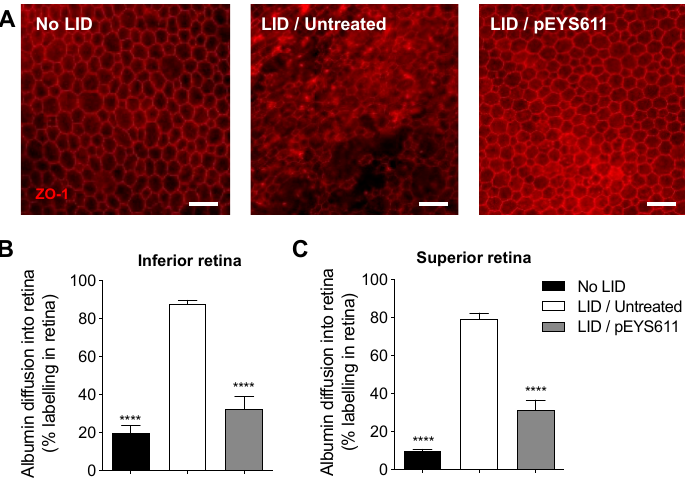
Figure 6. pEYS611 preserves the integrity of the outer BRB following light damage. Rat received a single ciliary muscle electrotransfection of pEYS611 (30 µg/eye) on D-3 or left untreated ( n = 8 animals/group). Except for unexposed animals (no LID), retinal degeneration was induced on D0 by 24 h of bright light exposure (6500 lux). ZO-1 and albumin staining were performed on D8. ( A ) Representative images of flat-mounted retina/RPE/choroid ZO-1 staining at a distance of 1500–2000 µm from the ON. Scale bar, 50 µm. ( B , C ) Albumin into the retina was quantified in the inferior ( B ) and superior ( C ) poles of the retina. Percentage of albumin diffusion per retina section is presented as mean ± sem. **** p < 0.0001 using Tukey’s multiple comparisons test versus LID/untreated group.